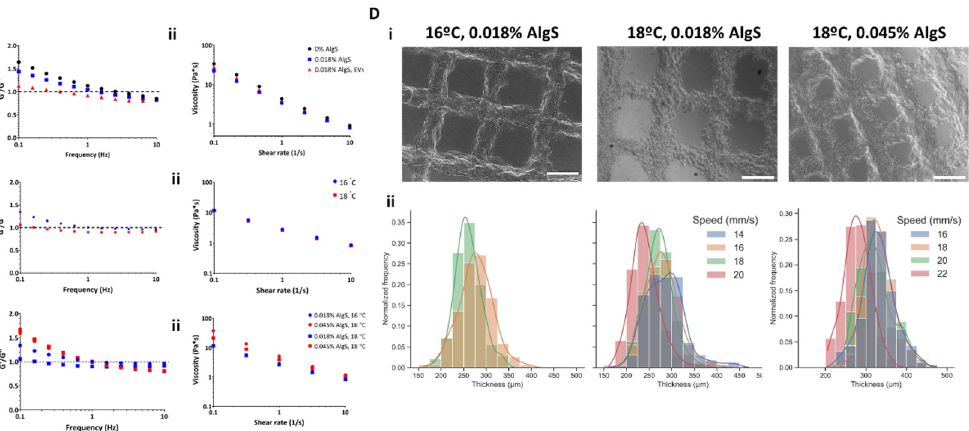
Figure 4. Three-dimensional bioprinting of alginate-based shell bioink solutions. ( A , B ) Mechanical spectra (i) and viscosity (ii) of 1.5% Alg, 0.36% Ca-gluconate ( w / v , black) solutions without any additives, with 0.018% AlgS ( w / v , blue) and 0.018% AlgS combined with 5 × 10 10 EVs/mL (red). In 1.5% Alg, 0.36% Ca-gluconate ( w / v ) bioink solutions, cross-point appears at lower frequencies with addition of AlgS and EVs (red dashed lines). ( B ) Mechanical spectra (i) and viscosity (ii) of 1.5% Alg, 0.36% Ca-gluconate ( w / v ), 0.018% AlgS ( w / v ) solutions in 16 (blue) and 18 ° C (red). ( C ) Mechanical spectra (i) and viscosity (ii) of 1.5% Alg, 0.36% Ca-gluconate ( w / v ), 0.018% (blue) and 0.045% (red) AlgS content ( w / v ). ( D ) Printing analysis of shell bioink solutions. (i) Images of 3D bio-printed grid patterns and (ii) strand thickness distribution plots, printed at different velocities, fabricated using 0.018% shell bioink printed at 16 (left) and 18 ° C (middle), and 0.045% shell bioink printed at 18 ° C (right). Scale bar: 500 µm.